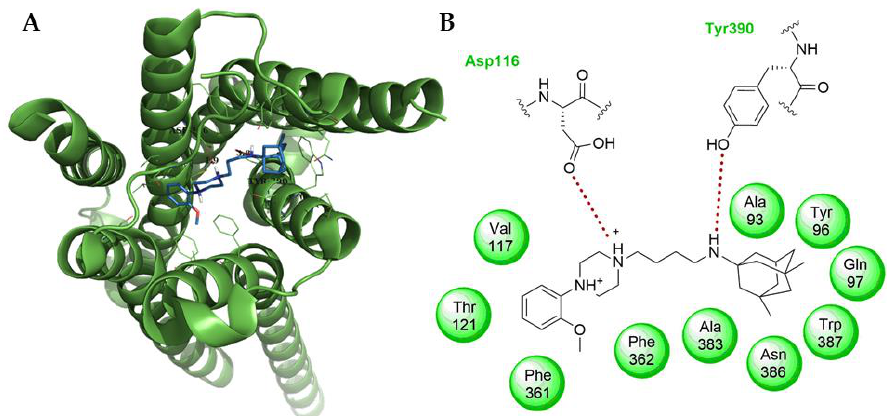
Figure 3. ( A ) Green cartoon representation of the 5-HT 1A receptor with the presence of ( 8 ) at lowest scoring function binding mode as obtained from the software OpenEye in blue colored sticks, ( B ) 2D representation of ( 8 ) binding network forming as obtained from OpenEye software. Brick red dashed lines represent HB between receptor and ( 8 ).